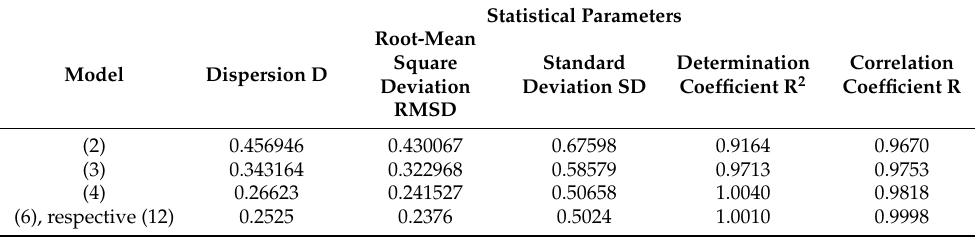
Figure 3. Graphical results of the weight loss profile obtained using the mathematical models (6) and (9). Left: measured values vs. values obtained from Equation (12) with MATLAB function plot . Right: w ( t ) curve using model (9) with parameters (11). Table 2. Statistical indicators—comparative table for models (2), (3), (4), and (6) in the form of Equation (12).